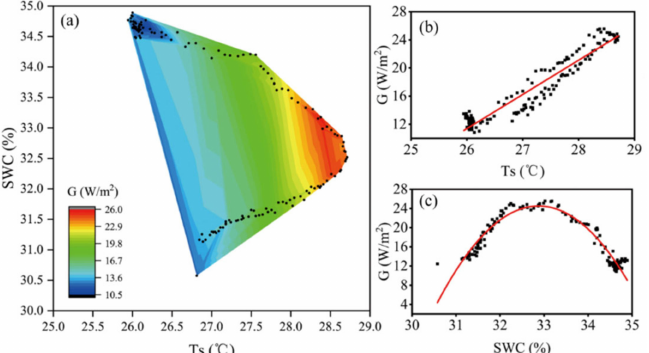
Figure 5. Relationships between soil temperature ( Ts ), soil water content ( SWC ) and soil heat flux ( G ) in the C CH over a 24 h cycle in summer. ( a ) Contour plot showing relationships between Ts , SWC and G ( n = 144). ( b ) Regression curve of Ts vs. G . Linear fitted regression of Ts and G ( r 2 = 0.91, p < 0.05, n = 144). ( c ) Regression curve of SWC vs. G . Polynomial fitted regression of SWC and G ( r 2 = 0.90, p < 0.05, n = 144).